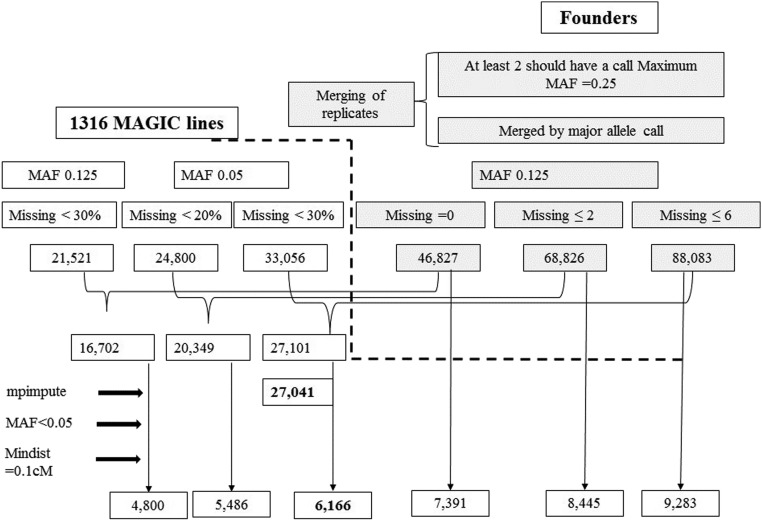
Filtering for SNP markers from GBS marker data in founders and lines (post-GBS pipeline). The scheme shows the use of different criteria resulting in multiple sets of SNP marker sets, emphasizing the impact of filtering criteria on downstream results. GBS, genotyping by sequencing; MAF, minor allele frequency; Mindist, minimum distance between any two markers; SNP, single nucleotide polymorphism.